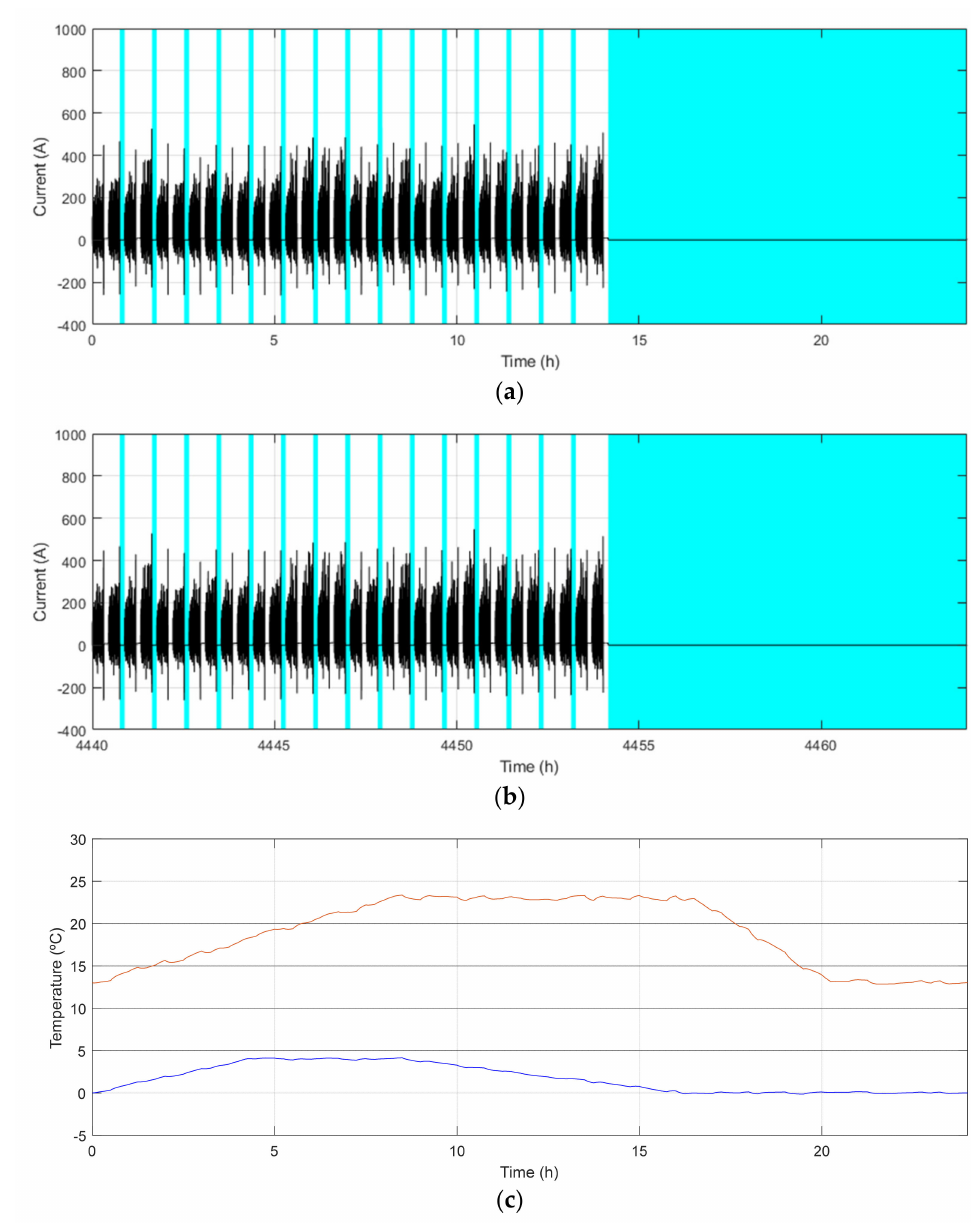
Figure 6. Current and temperature profiles in OSN scenario. ( a ) Current profile, 1 January. Cyan: Charging Points. ( b ) Current profile, 1 July. Cyan: Charging points. ( c ) Temperature Profile. Blue: January; Red: